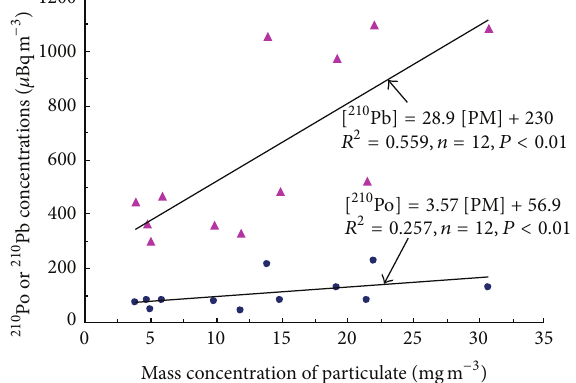
Figure 4: The correlation between the mass concentration of particulate(PM)and 210 Poor 210 Pbconcentrationsintheairsamples collected in ILVA Taranto in 11–17 November